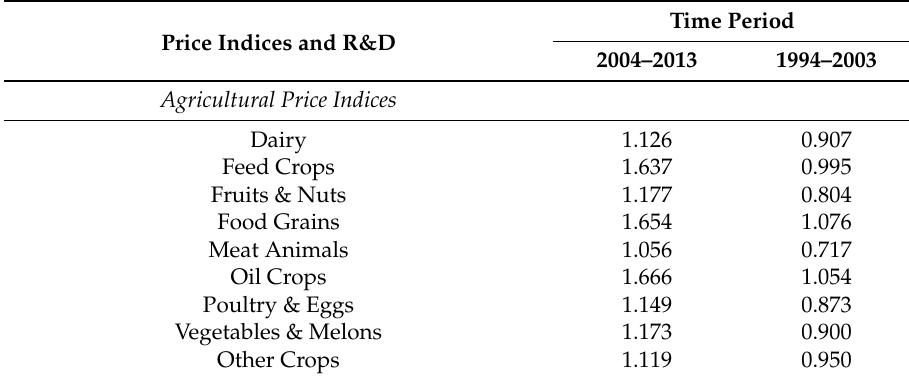
Table 3. R&D and the U.S. Agricultural Economy,